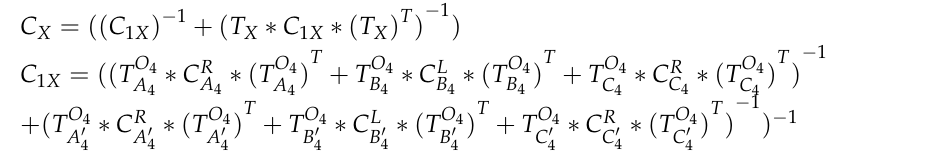
Figure 11. Analysis of x -direction hinge.